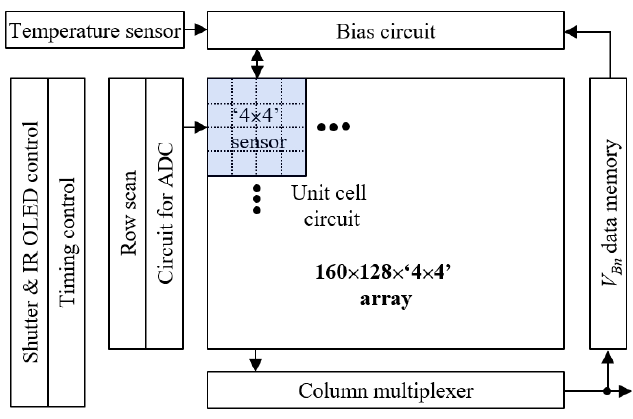
Figure 5. Block diagram of the overall arrangement for the proposed ROIC.